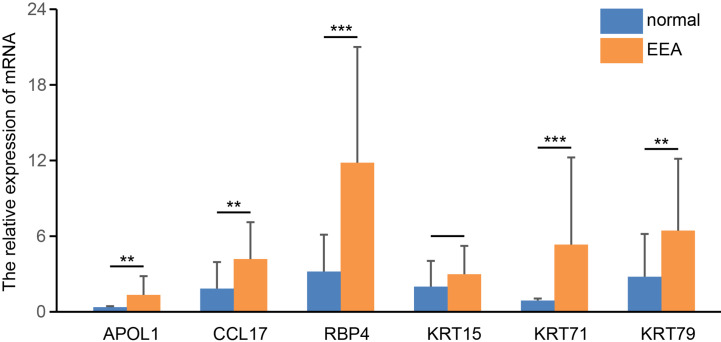
The relative expression level of 6 hub genes in EEA and normal samples. ** and *** indicate p < 0.01, p < 0.001, respectively.